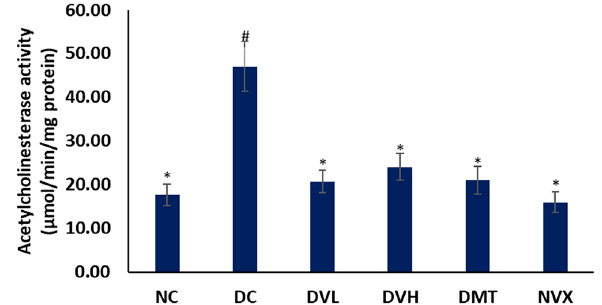
Figure 4. Acetylcholinesterase activities of experimental groups. Value = mean ± SD; n = 5. *Statistically significant ( p < 0.05) to DC; #Statistically significant ( p < 0.05) to NC. NC = normal rats, DC = diabetic control, DVL = diabetic rats + vanillin (150 mg/kg b.w), DVH = diabetic rats + vanillin (300 mg/kg bw), DMT = diabetic rats + metformin (200 mg/kg b.w), and NVX = normal rats + vanillin (300 mg/kg